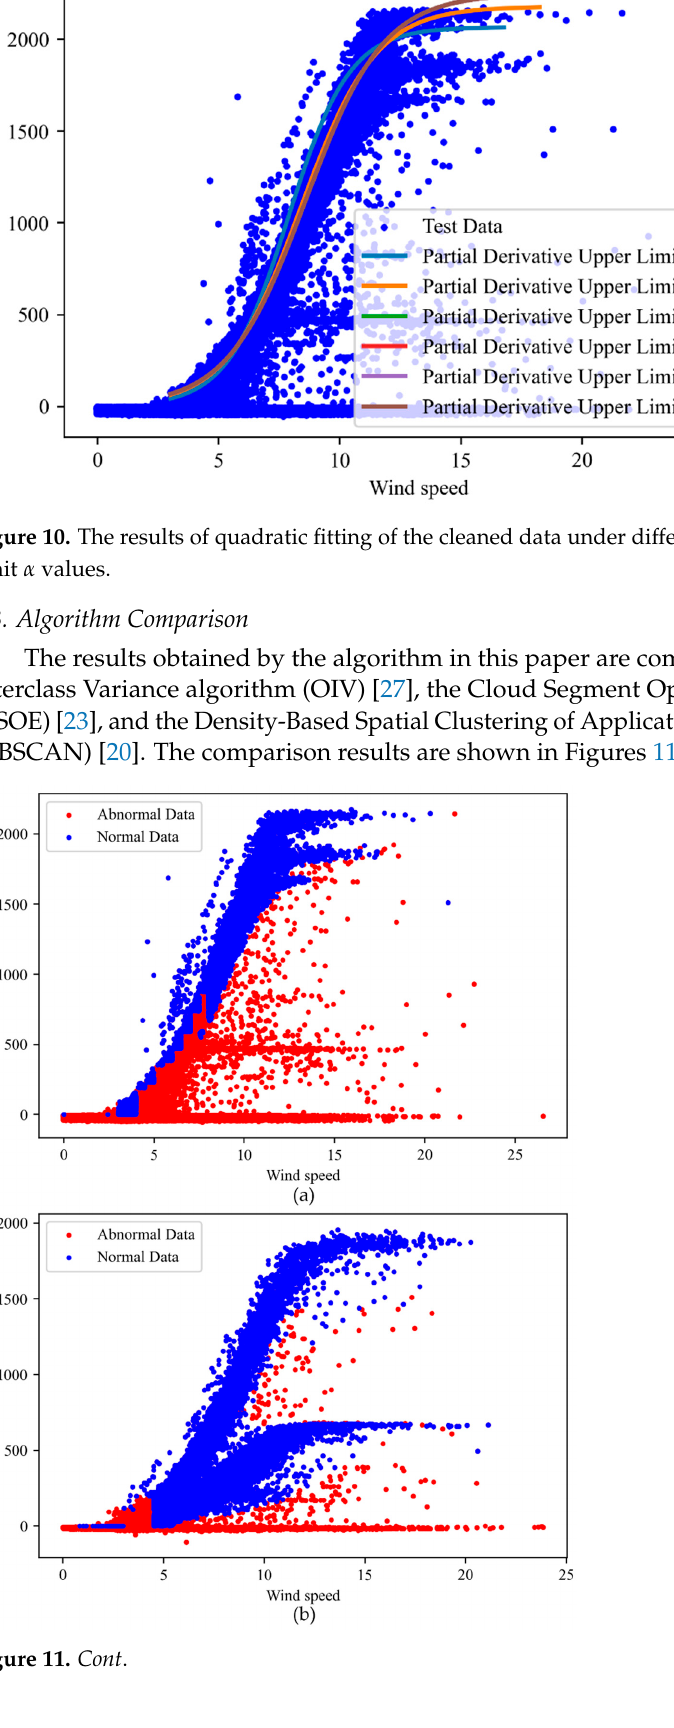
Figure 11. Abnormal data cleaning results using the OIV algorithm: ( a ) #1 wind turbine; ( b ) #2 wind turbine; ( c ) #3 wind turbine.